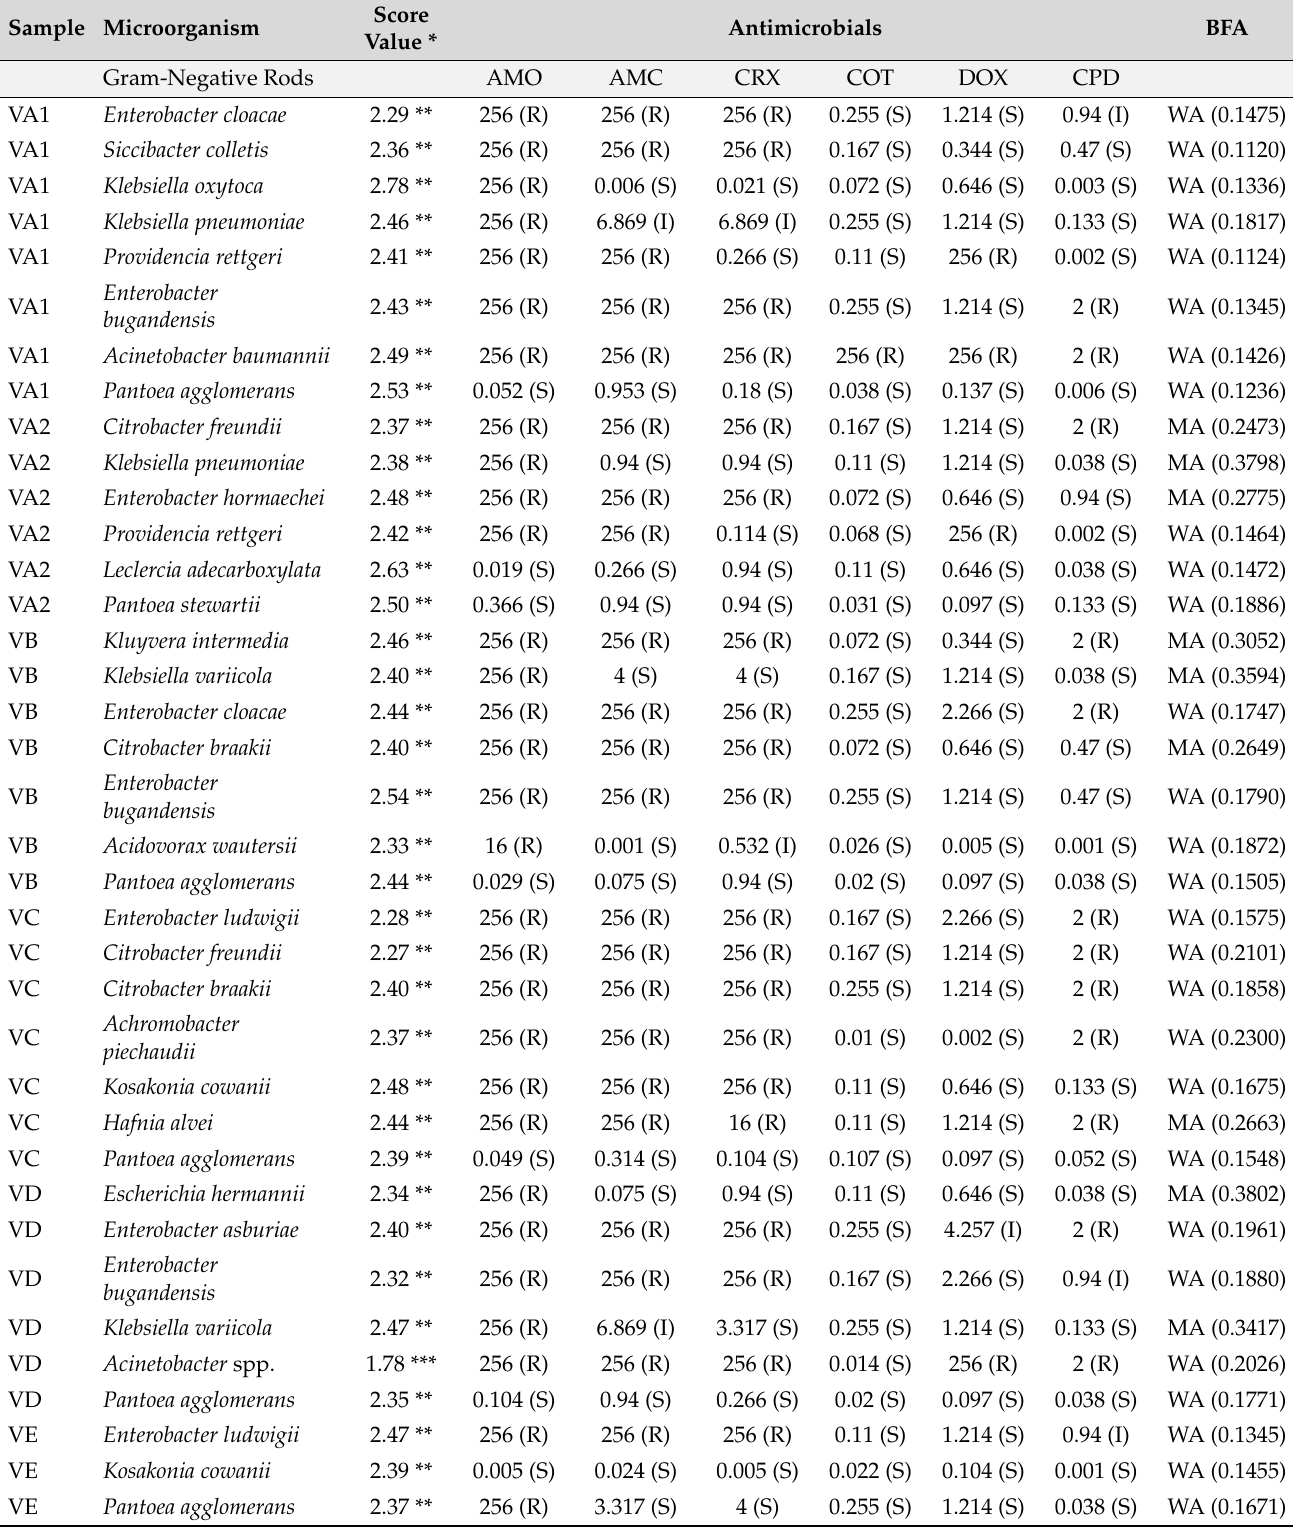
Table 5. Identified microorganisms isolated from vegetable smoothie drink samples with their biofilm formation ability and susceptibility to antimicrobials expressed as minimum inhibitory concentration ( µ